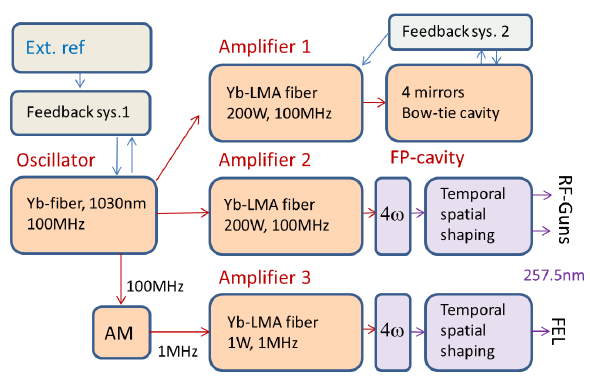
Figure 8. General layout of the optical system.